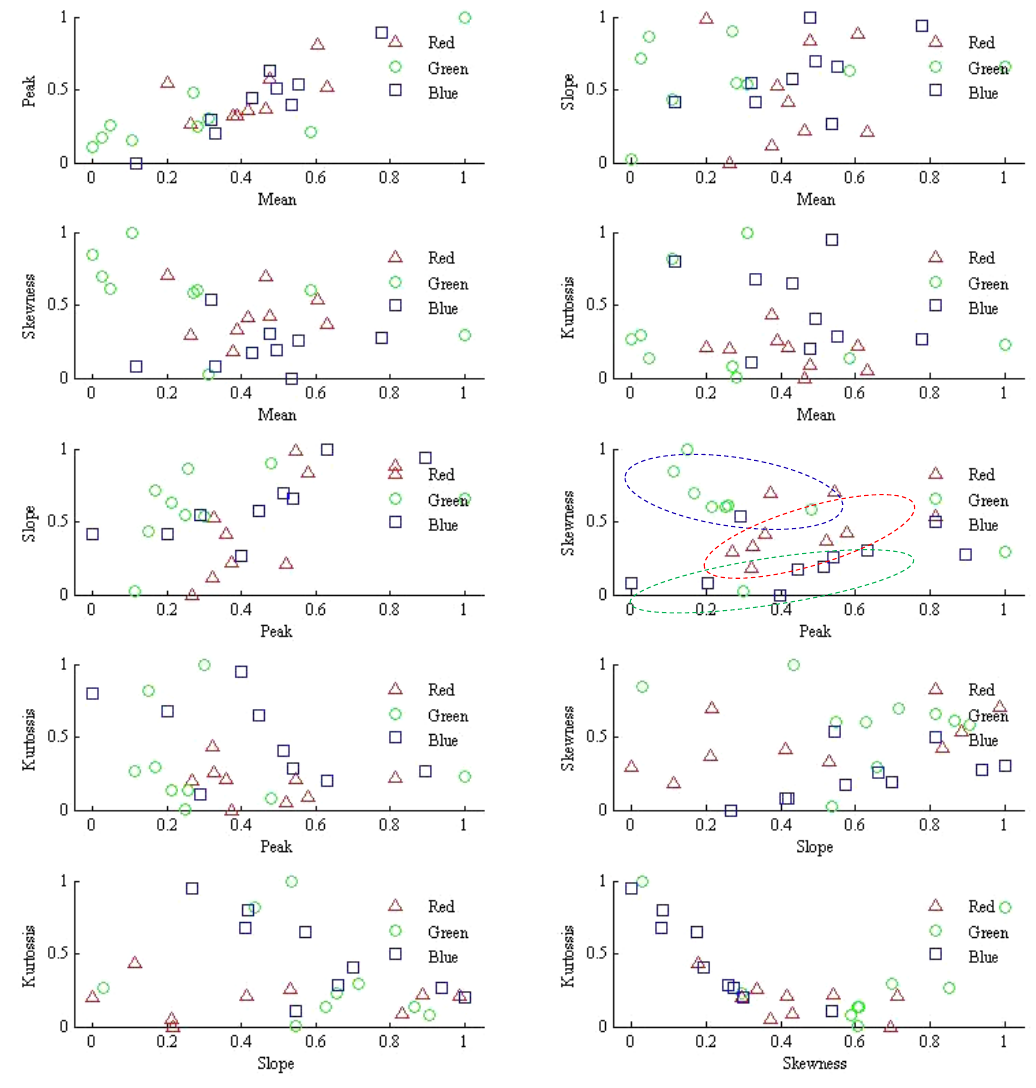
Fig. 5. Feature spaces in combination of mean, peak, slope, skewness, and kurtosis for distinguishing RGB-color stimuli (Subject 1): The triangle represents red-color the circle represents green-color and the square represents